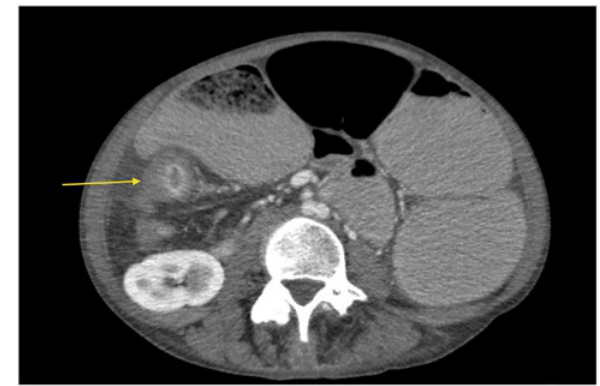
Figure 6a: Axial CT in a known haemophiliac showing SBO secondary to a large hyperdense haematoma (arrow)